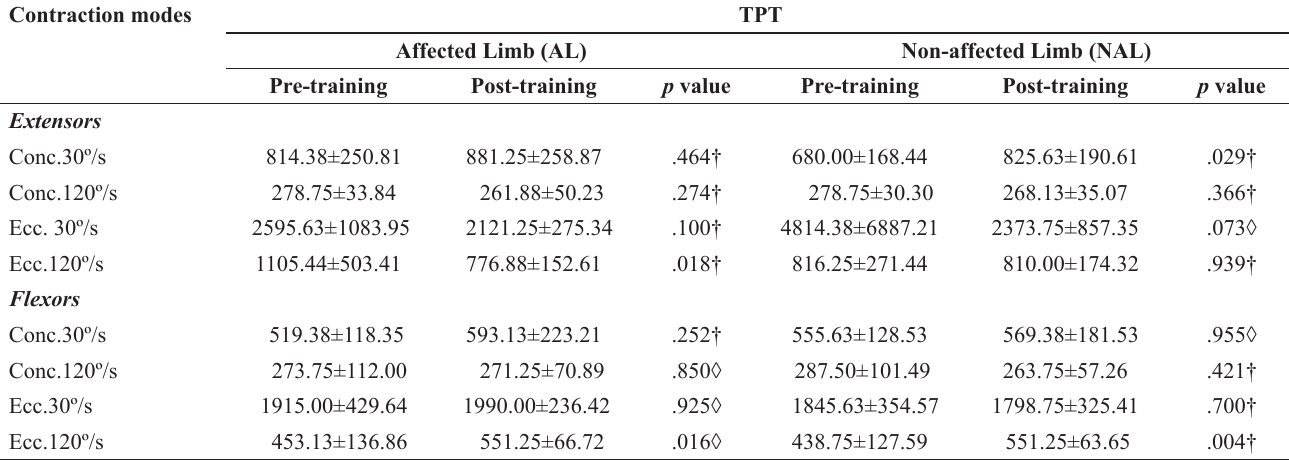
3. Average values of time to peak torque (TPT) of the knee movements in the isokinetic dynamometer.